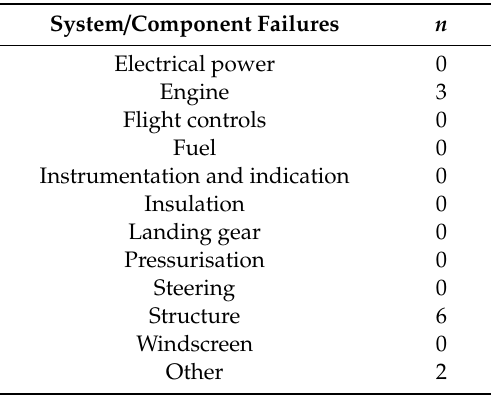
Table 7. Level 2 System / Component